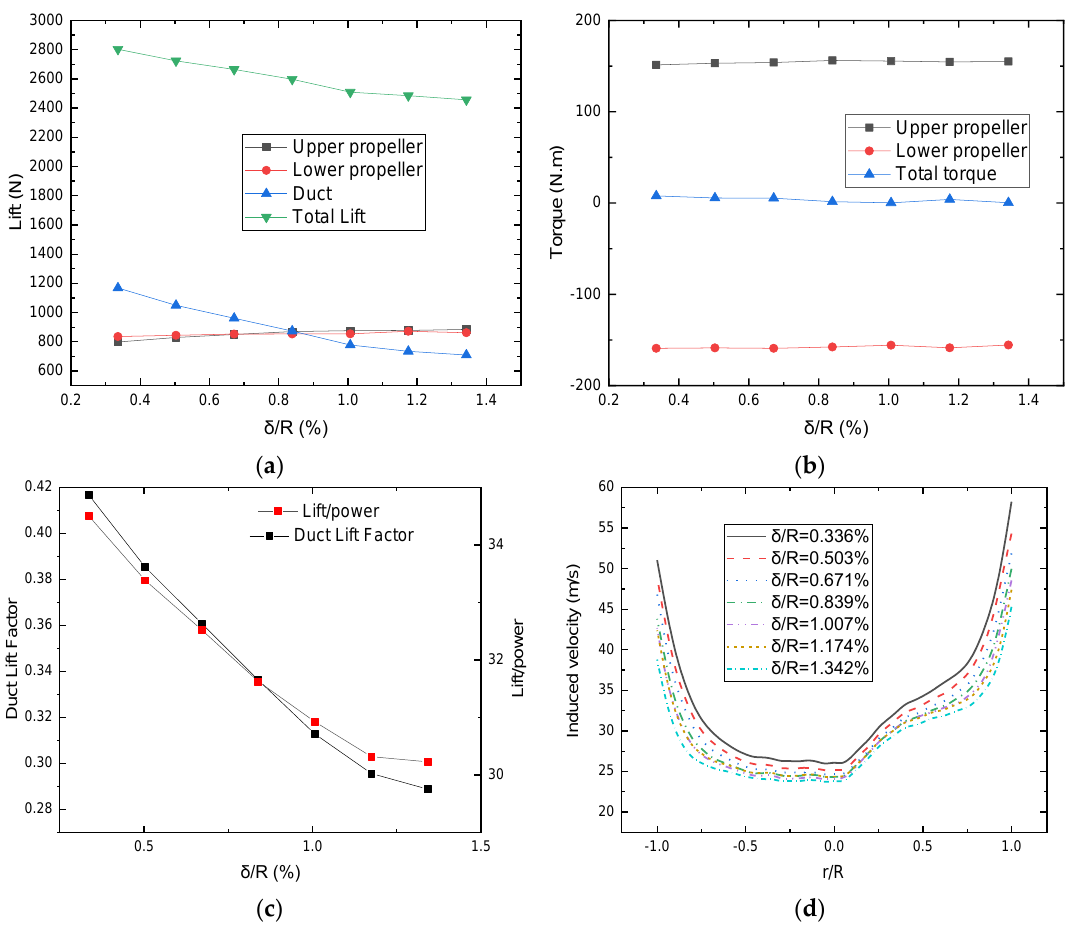
Figure 11. Relationship between aerodynamic characteristics and tip clearance ratio: ( a ) relation- ship between lift and tip clearance ratio; ( b ) relationship between torque and tip clearance ratio; ( c ) aerodynamic efficiency and duct lift factor of DCP; ( d ) induced velocity of duct lip’s cross-section.